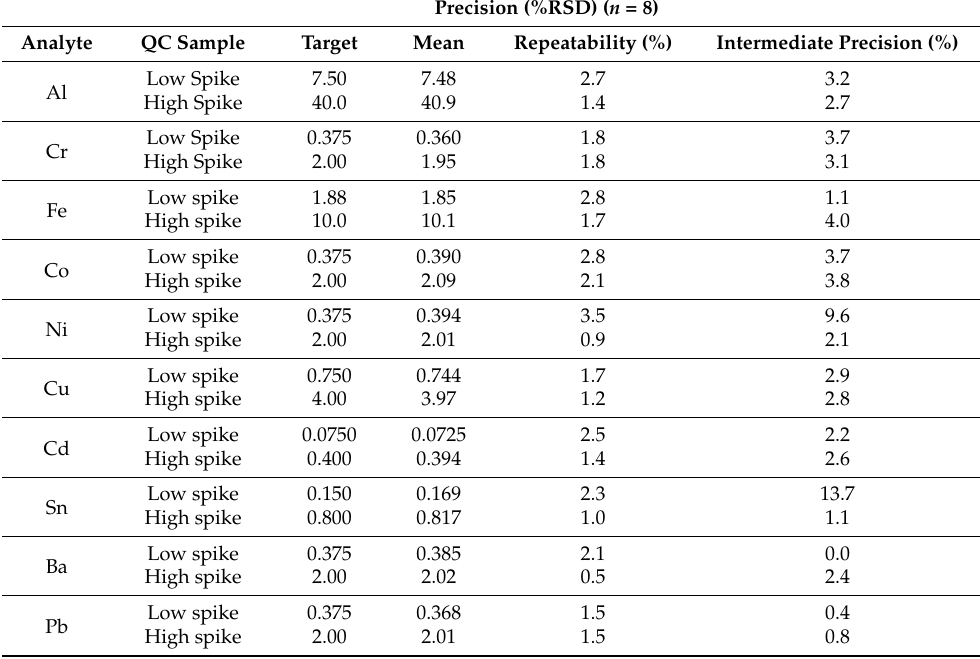
Table 4. Method precision using 8 duplicate runs of quality controls (QCs), µ